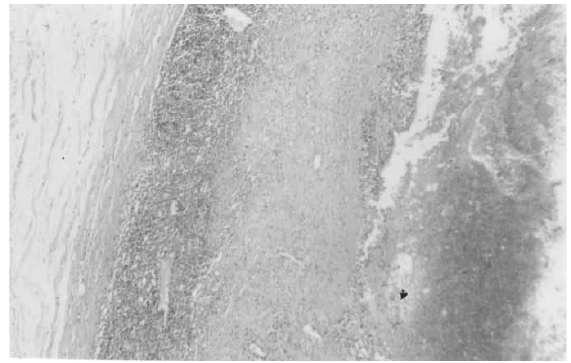
Fig. 6. The lymph node sections show a peripheral thin rim of uninvolved tissue (on the left) and large hemorrhagic space surrounded by neoplatsic cells similar to primary (H&E, (cid:1) 4).